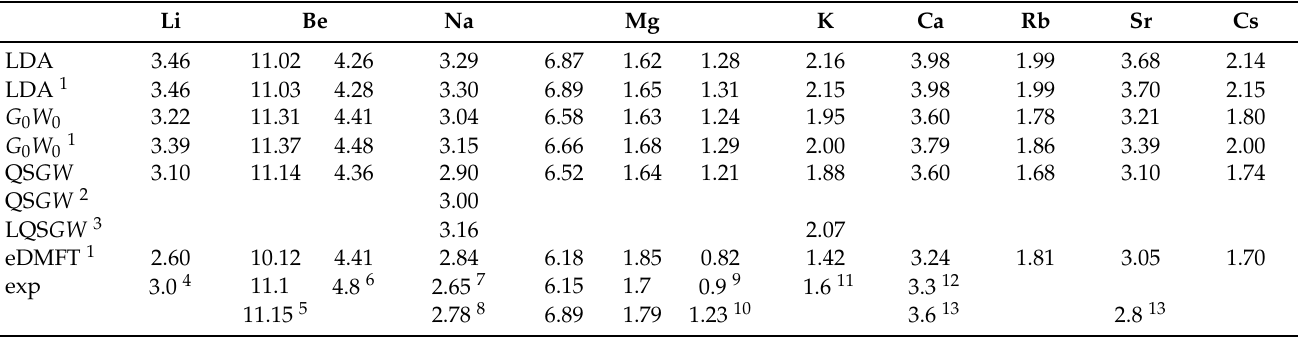
Table 3. Valence bandwidths (in eV) obtained from LDA, G 0 W 0 , QS GW , LQS GW , and eDMFT compared to experimental reference